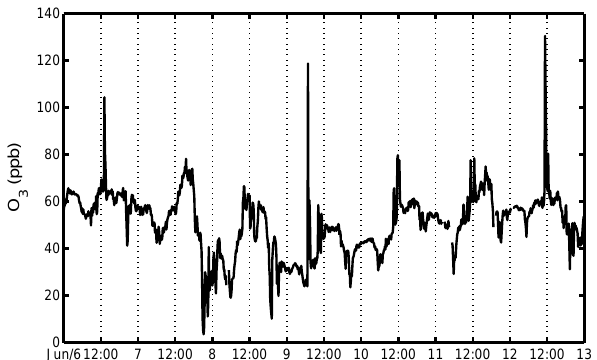
Figure 9. High ozone spikes around the noon during 6 and 13 June 2012 in